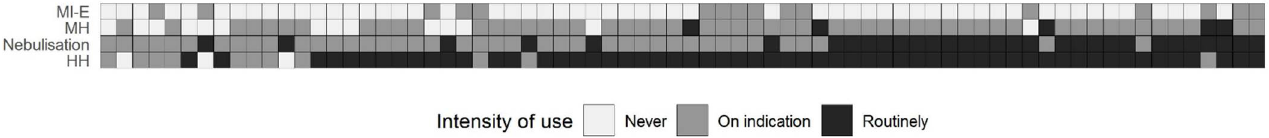
Figure 1. Heatmap airway care interventions in Dutch ICUs (N = 72). Current practice of heated humidification (HH), nebulization therapy, manual hyperinflation (MH) and MI-E in Dutch ICUs is graphically displayed in a heatmap. Each vertical bar is one ICU. Intensity of use of the airway care interventions is visualized by different shadings of grey according to the legend.